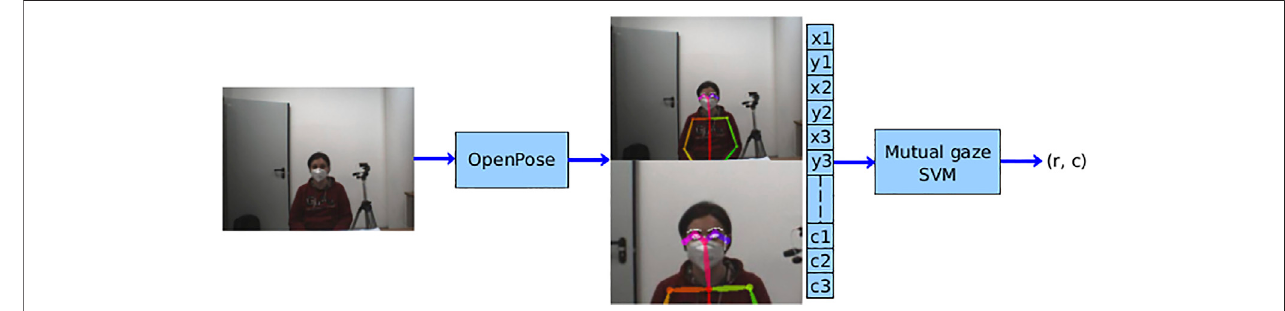
FIGURE 2 | Learning architecture. The acquired image is fi rst used as input for OpenPose in order to get the facial keypoints and build the feature vector for the individual in the scene. Then, such a feature vector goes in as input to the mutual gaze classi fi er whose output is the pair ( r , c ), where r is the binary result of the classi fi cation (eye contact/no eye contact) and c is the con fi dence